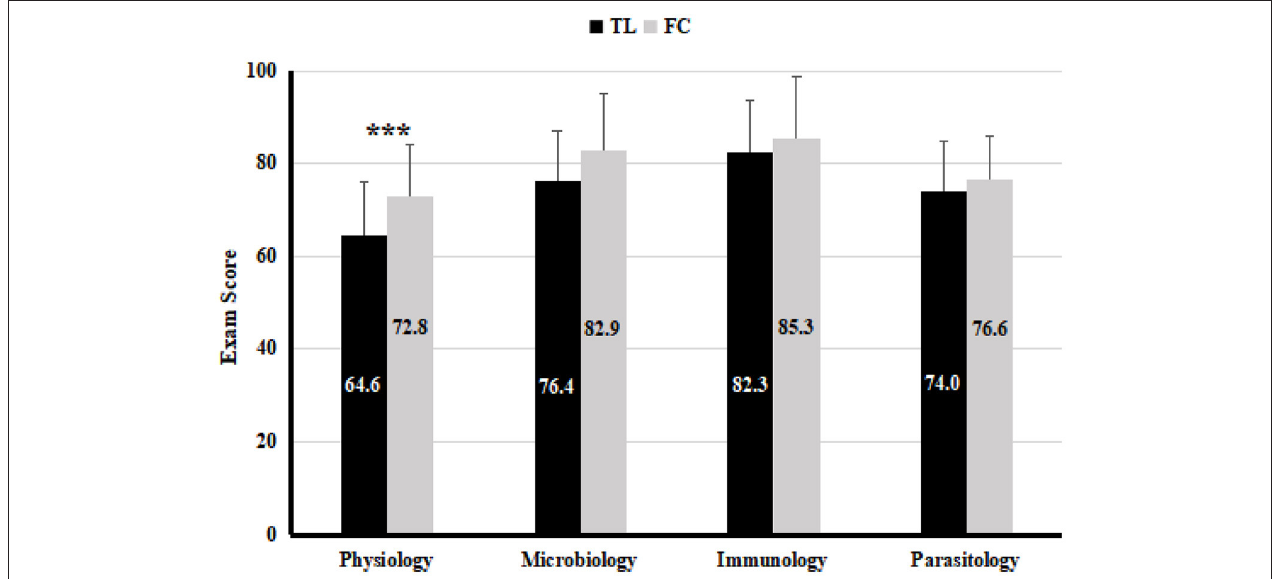
FIGURE 3 | The average exam scores of follow-up basic medical subjects with physiology in the TL teaching class ( n = 61) and FC teaching class ( n = 58), analyzed by T -test. Values are means ± SD. * P < 0.05, ** P < 0.01.